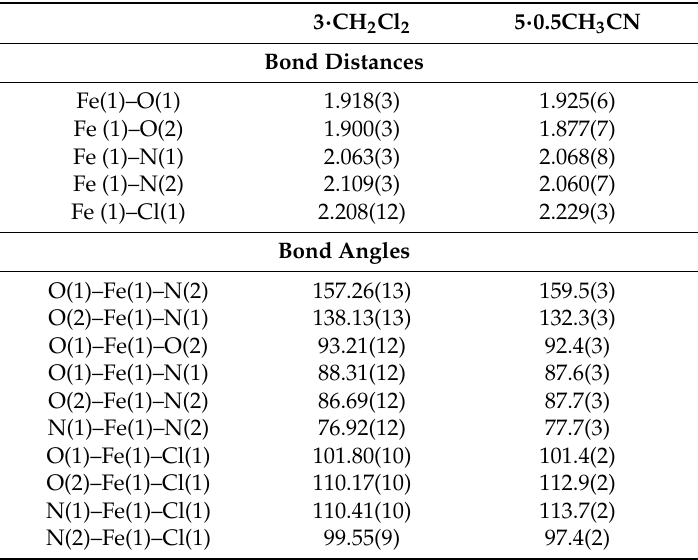
Table 2. Selected bond distances (Å) and angles ( ◦ ) within the first [Fe(N 2 O 2 )Cl] coordination sphere for compounds 3 · CH 2 Cl 2 and 5 · 0.5CH 3